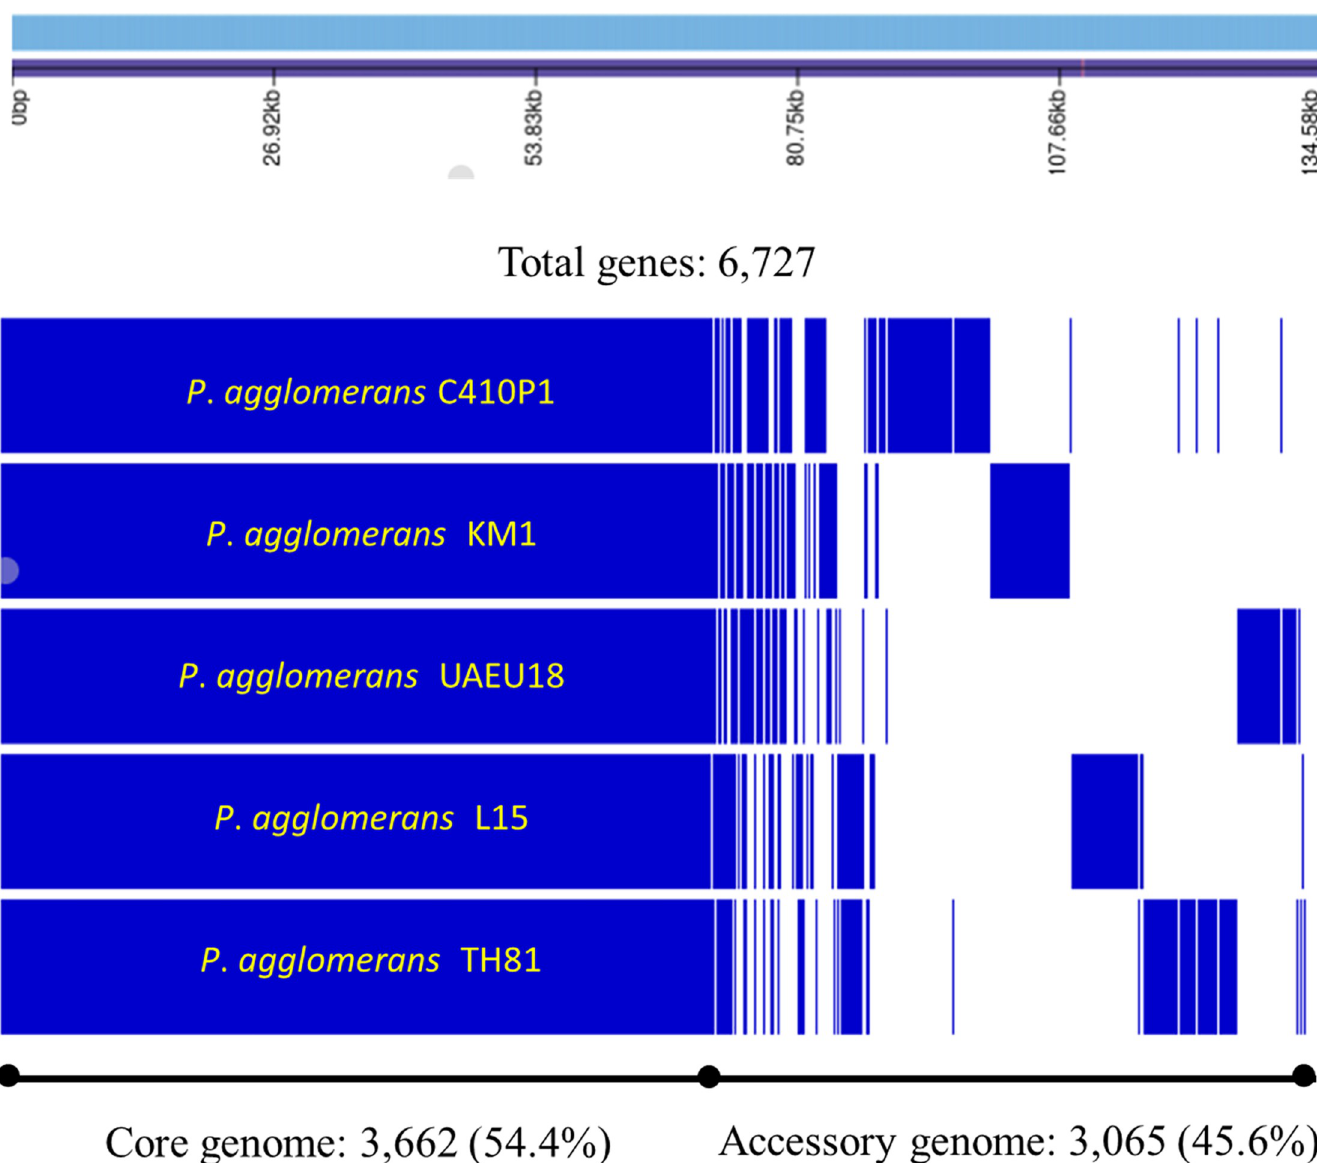
Fig 6. Roary matrix-based pan-genome analysis of P . agglomerans strains. The core-genome tree generated was compared with a matrix where the core and accessory genes were either present (blue) or absent (white).